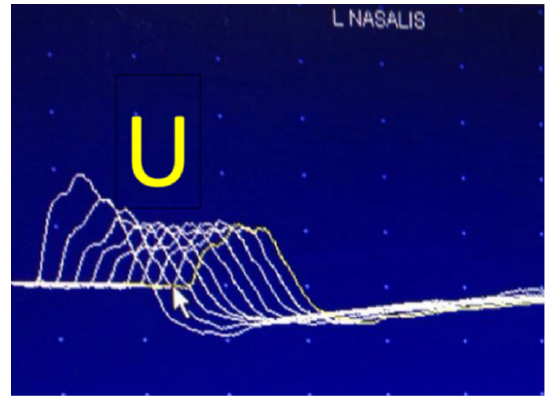
Figure 3. Abnormal decrement in the nasalis muscle in a U-shaped pattern.